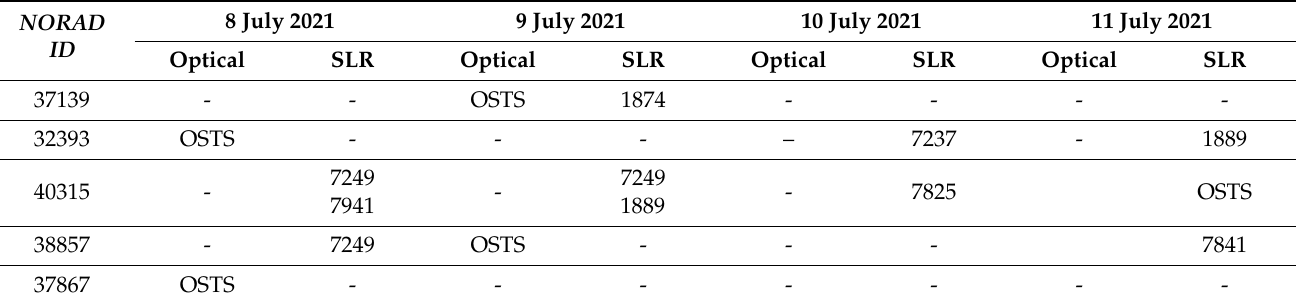
Table 3. The observations from optical and SLR stations.